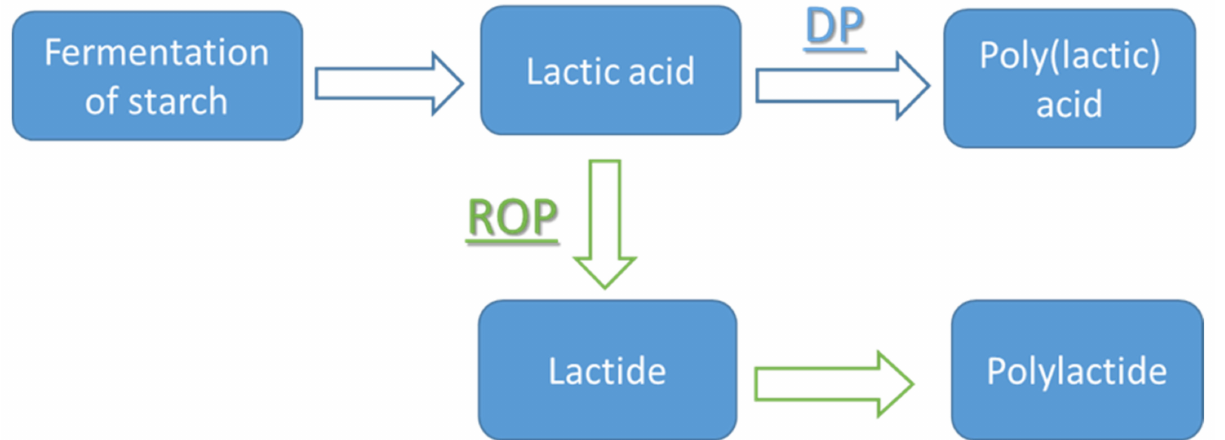
Figure 2. Available routes to obtain PLA, ring-opening polymerization (ROP), and direct polymerization (DP). Polylactide is a synonym for poly(lactic)acid (PLA), and the names can be used